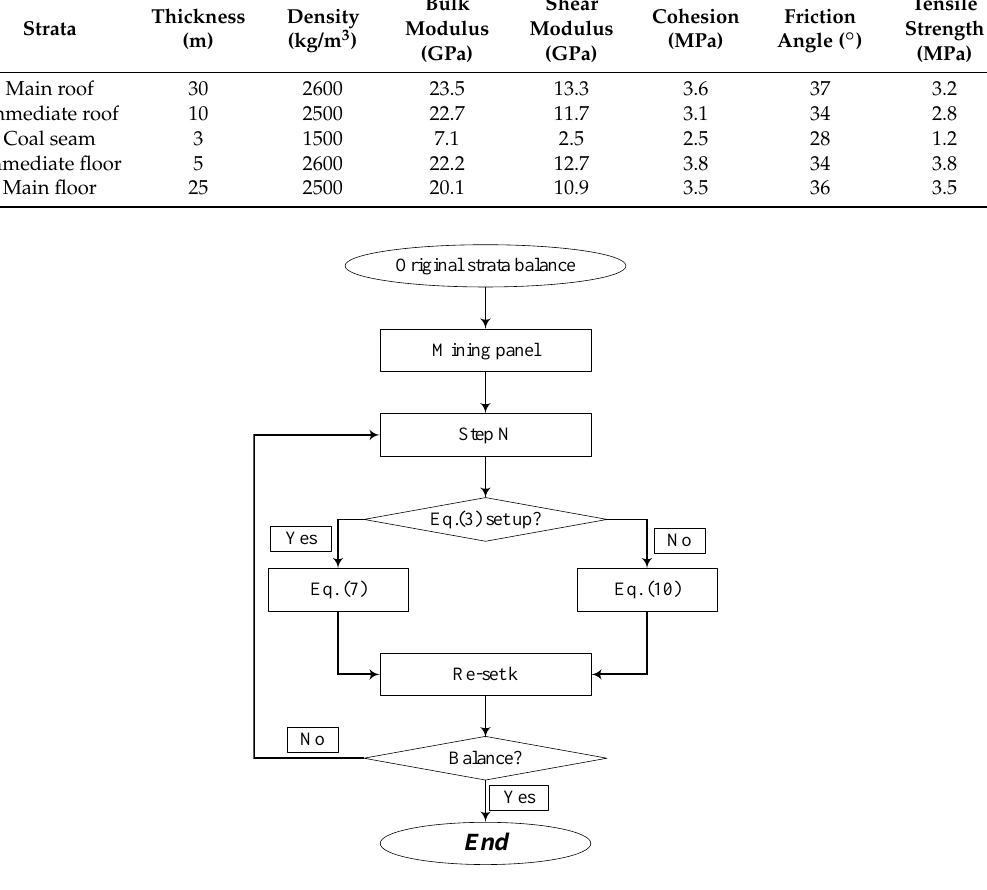
Figure 9. Computing procedure of the stress evolution.